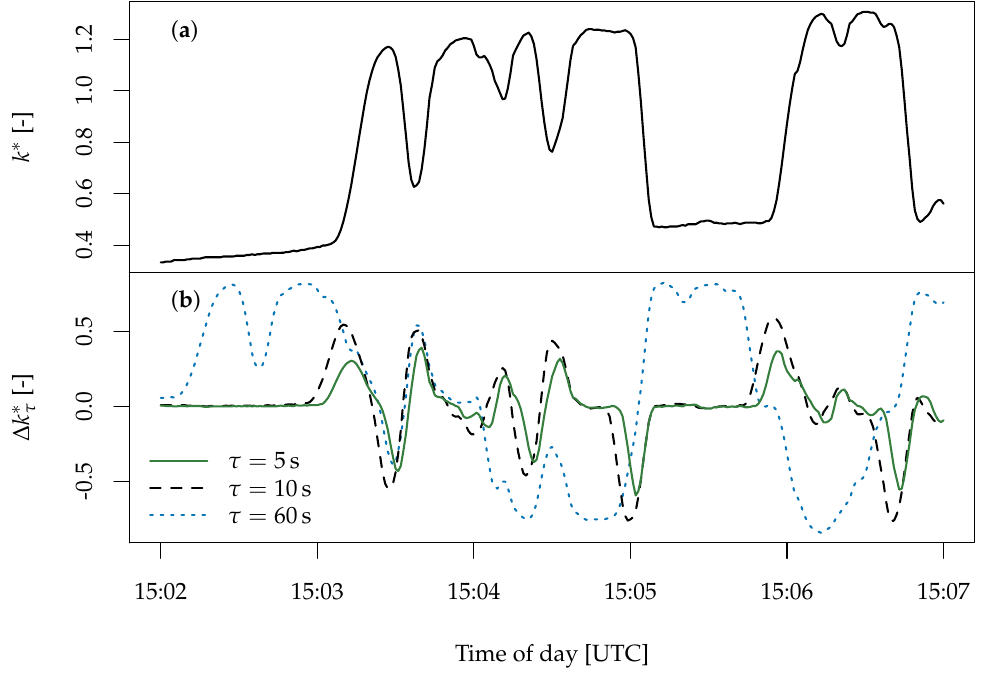
Figure 3. A five-minute subset of the time series previously shown in Figure 1 (there indicated by a vertical gray line). ( a ) Clear-sky index k ∗ time series; ( b ) Corresponding clear-sky index increments ∆ k ∗ τ ( t ) as per Equation (5) for three distinct short-term increment time steps τ = 5s, τ = 10s, and τ = 60s. The underlying irradiance data were collected during the HOPE campaign